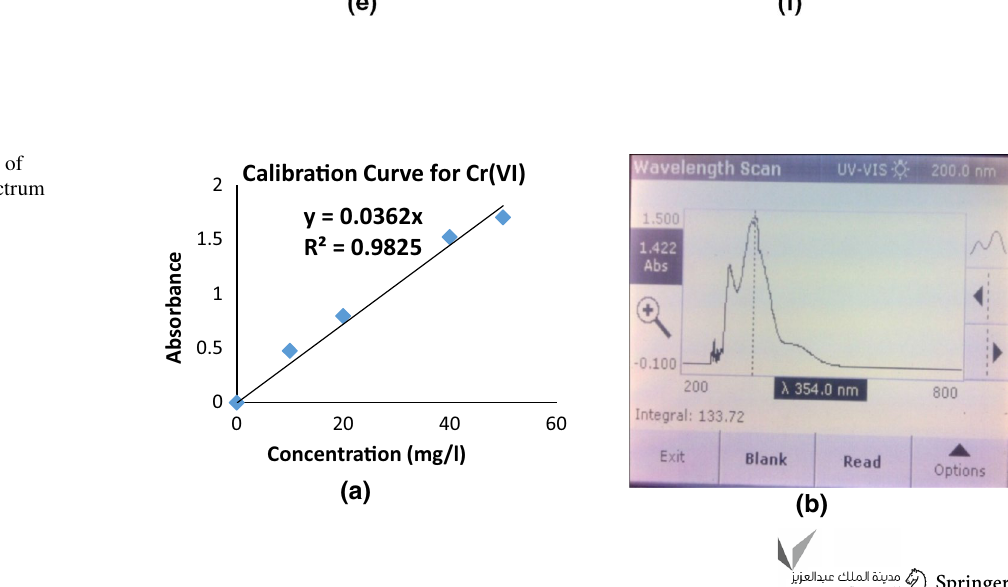
Concentra(cid:6)on (mg/l) (a)